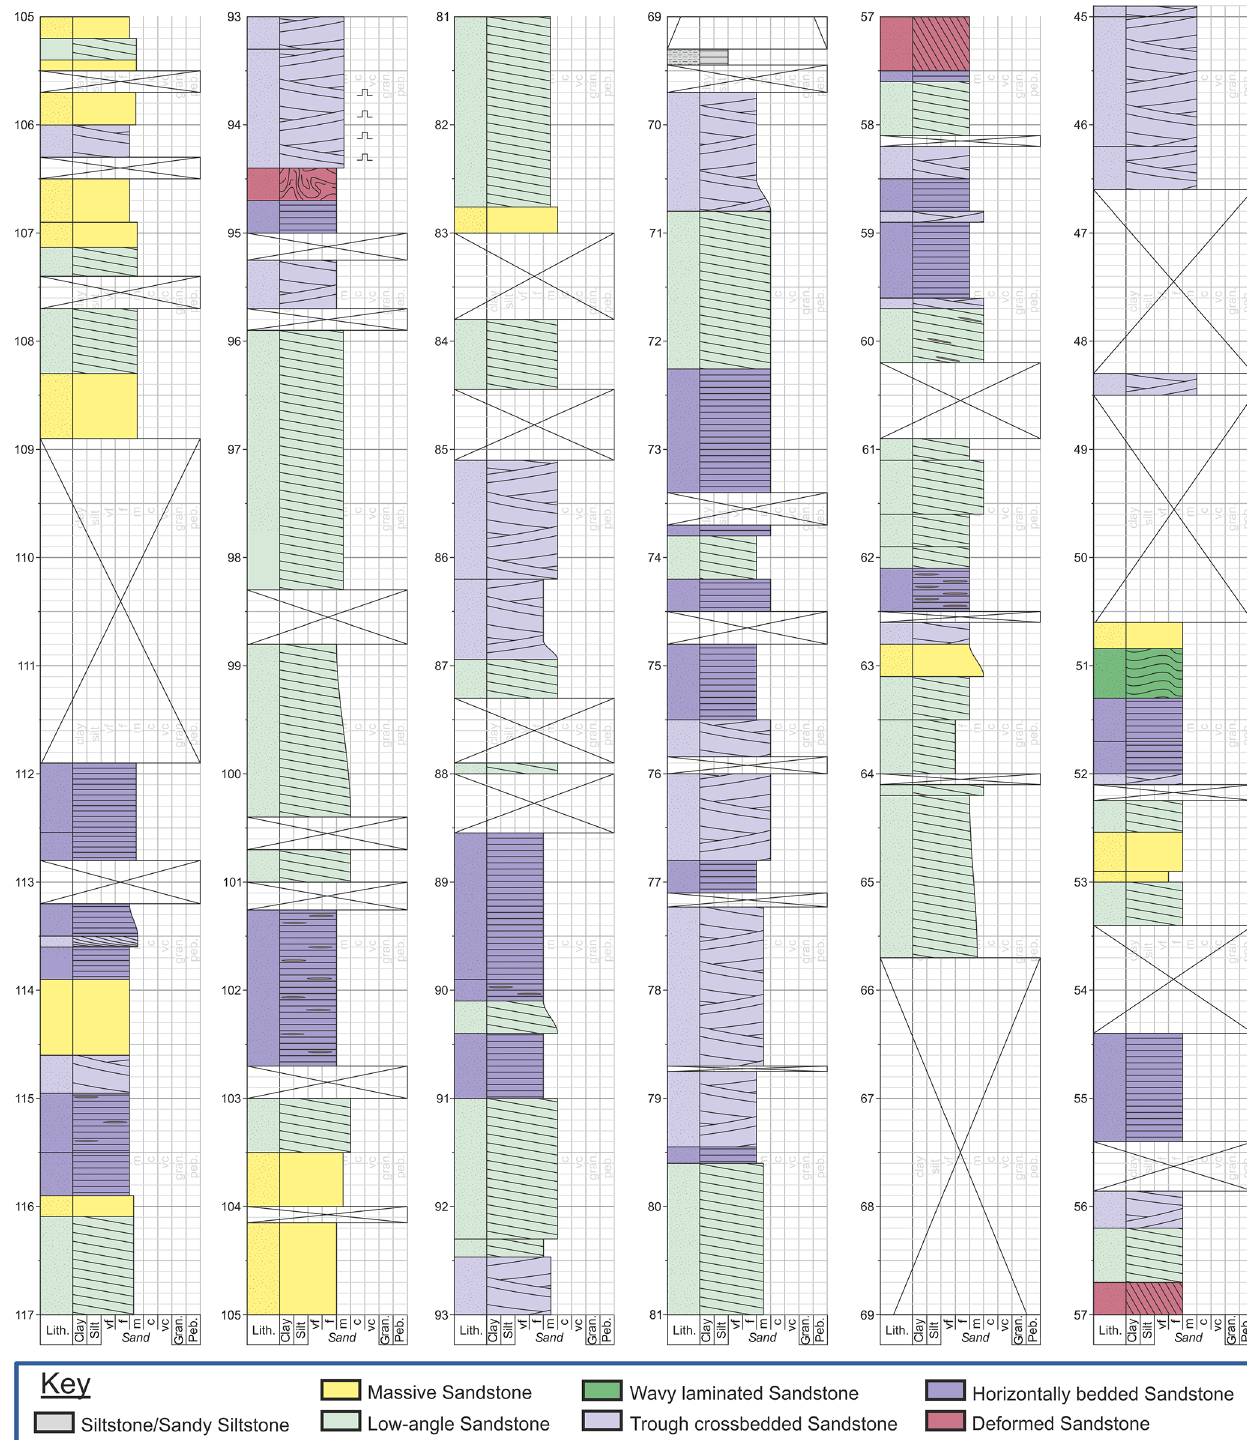
Figure 5. Lithological log of the Frodsham Marsh borehole core (BGS reference number SJ47NE/14).